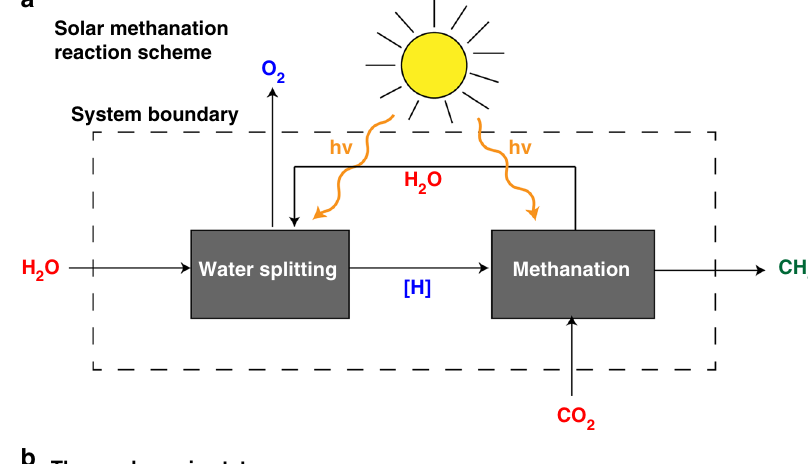
this can be either molecular H 2 or two H + /e − pairs (Fig. 2c).